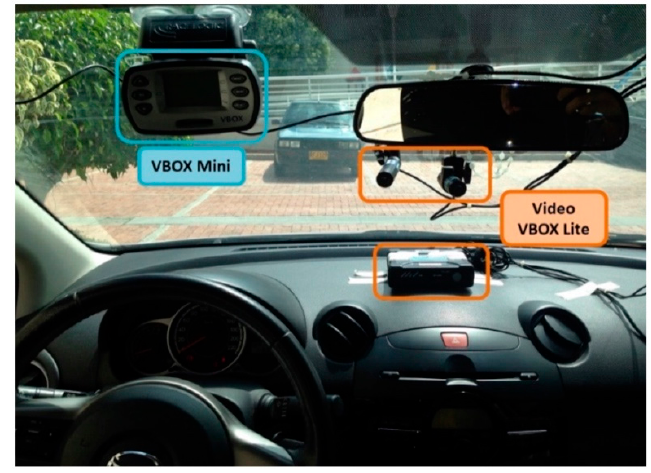
Figure 3. Vehicular Telemetry System (VTS).